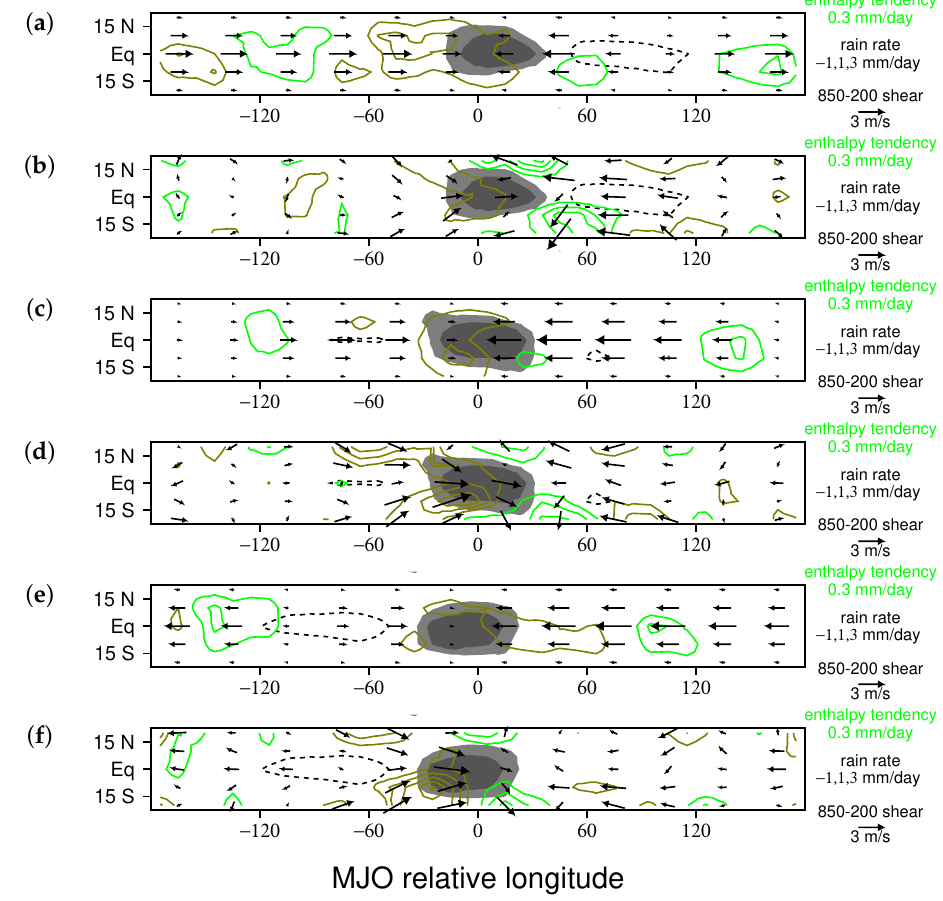
Figure 11. Moist enthalpy tendency owing to advection from the Kelvin ( a , c , e ) and Rossby ( b , d , f ) com- ponents of the LAM MJO for the developing, mature, and dissipating stages. Contoured and shaded as in Figure